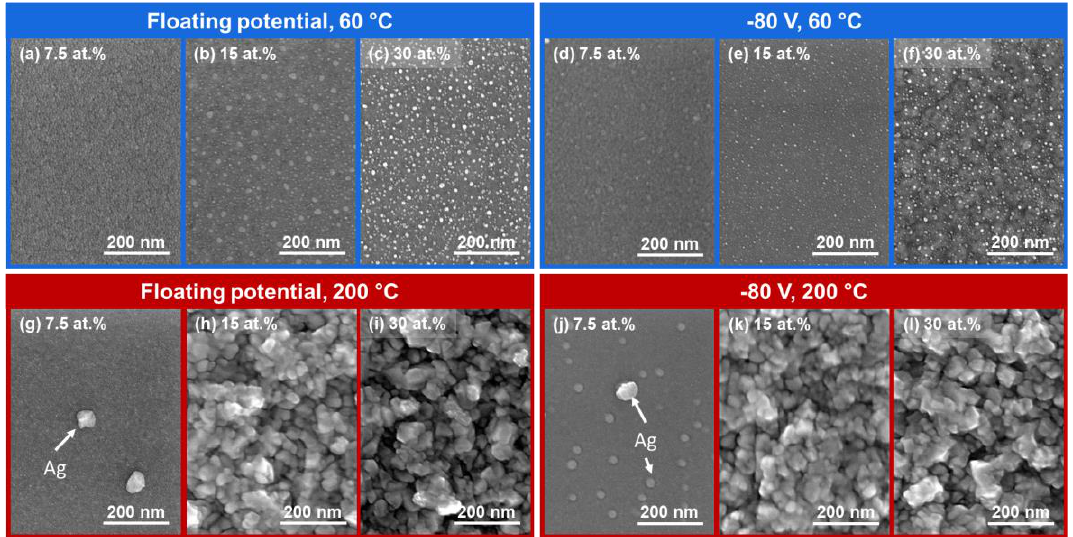
Figure 4. Scanning electron microscopy (SEM) surface micrographs of films of different Ag contents deposited at ( a – c ) floating potential; 60 °C, ( d – f ) −80 V; 60 °C, ( g – i ) floating potential; 200 °C, and ( j – l ) −80 V; 200 °C.